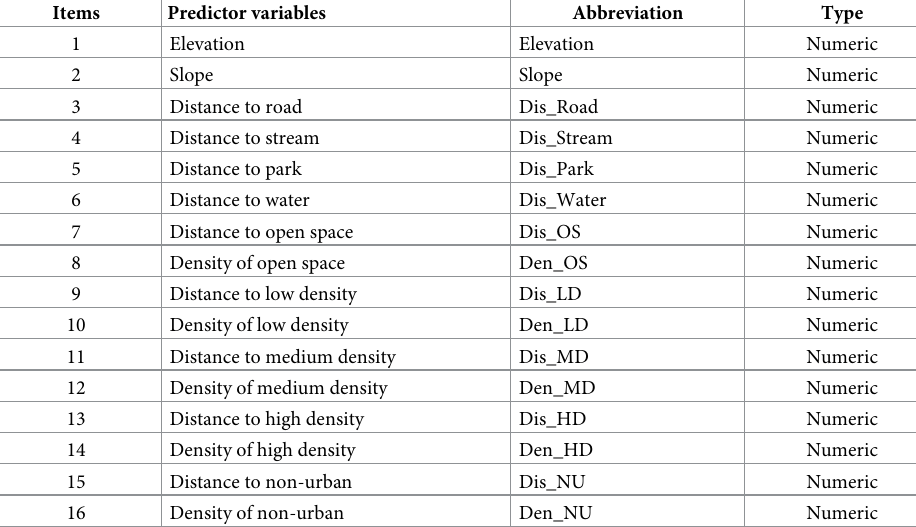
Table 2. Spatial predictor variables used in this study. Items Predictor variables Abbreviation